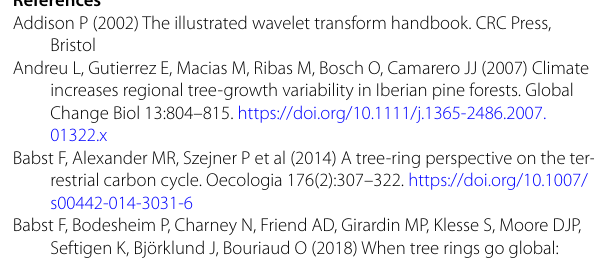
A i mean temperature of the month i of the current year; J i precipitation of the month i of the current year; R i air relative humidity of the month i of the current year; H i mean maximum temperature of the month i of the current year; P i PDSI of the month i of the current year; L i mean minimum temperature of the month i of the current year; PP i PDSI of the month i of the past